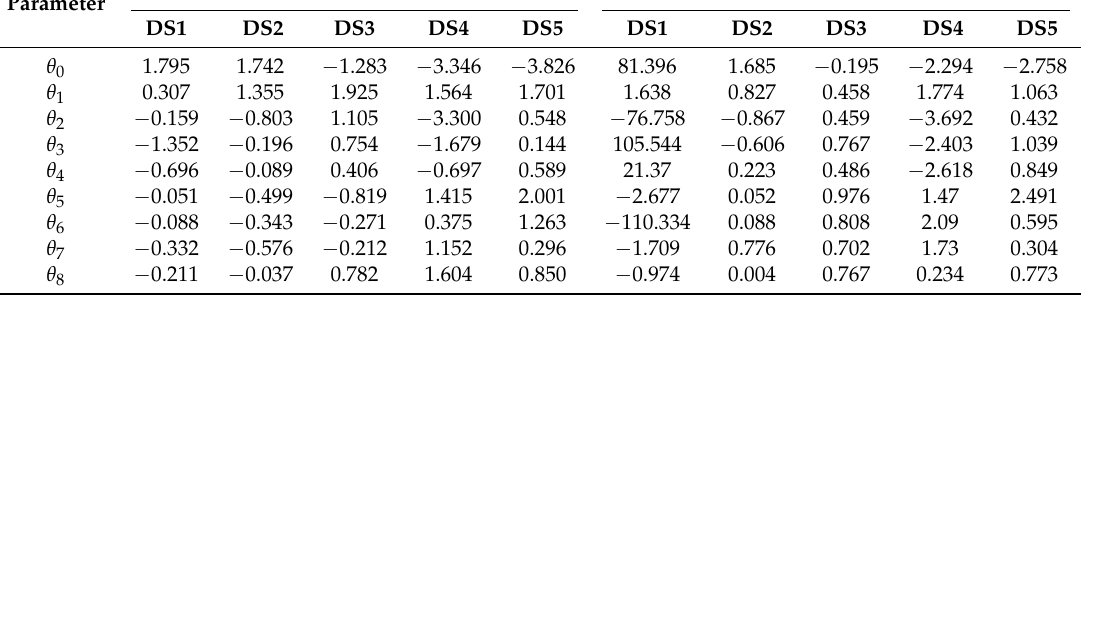
Figure 2. Fragility neglecting flow velocity for four structural types: ( a ) RC; ( b ) steel; ( c ) wood; and ( d ) masonry. Table 2. Regression parameters of bivariate-IM tsunami fragility considering flow velocity. Plain Parameter